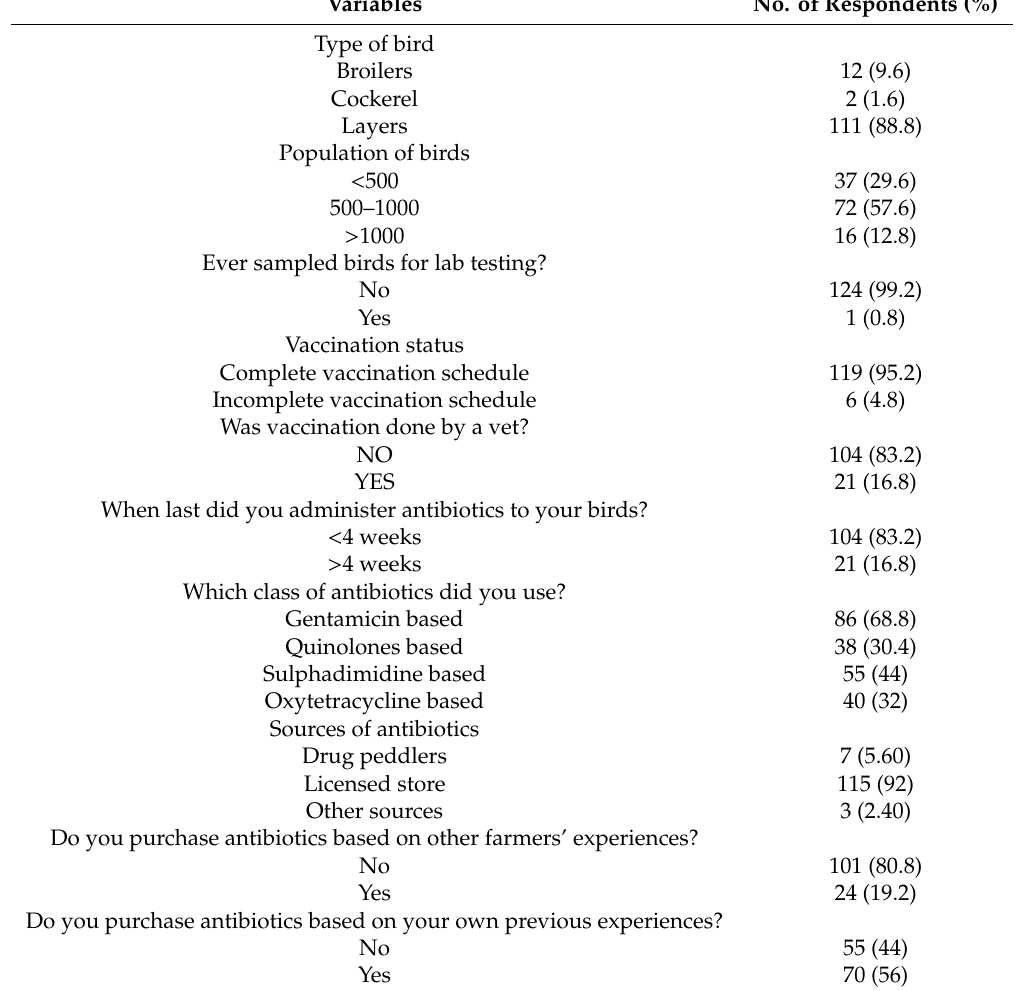
Table 4. Descriptive statistics on poultry flocks and antibiotic usage in selected poultry farms in Kwara state ( n =